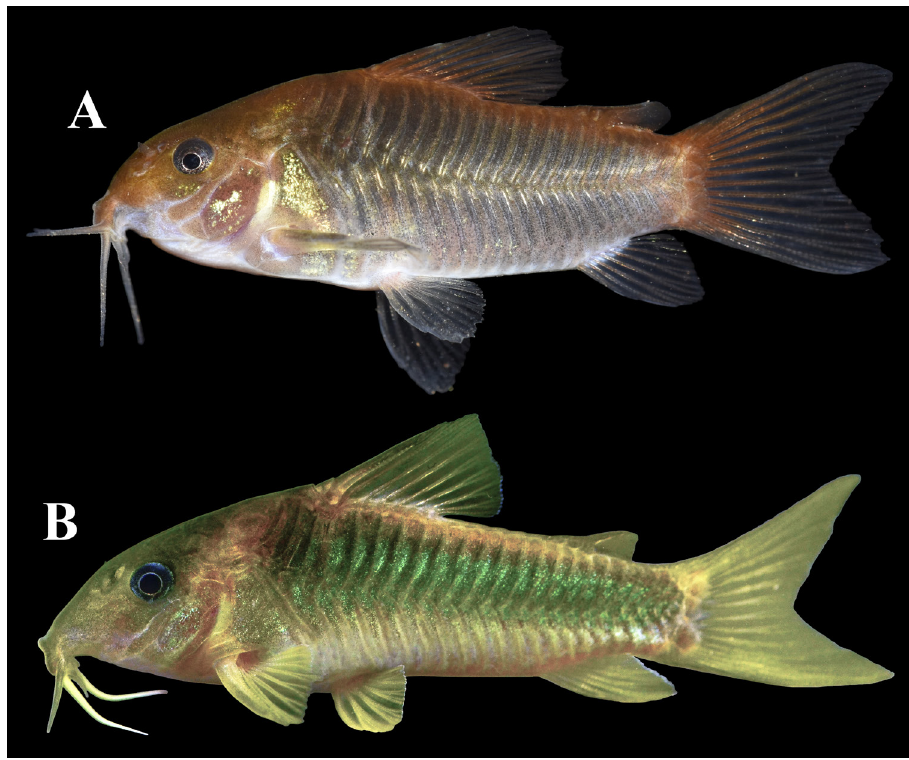
FIGURE 12 | Uncatalogued specimens (not measured) of ( A ) Corydoras hephaestus and ( B ) C. melanotaenia photographed alive in lateral view, showing general color and morphological patterns. Photograph ( A ) by Fernando Dagosta and ( B ) by Robert